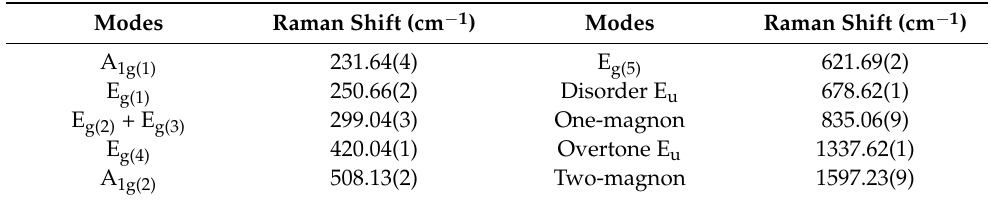
Table 1. Hematite Raman modes calculated from Lorentzian fits corresponding to the Raman spec- trum acquired at 80 K (in the heating process, Figure 4a) for the nanoparticulated hematite